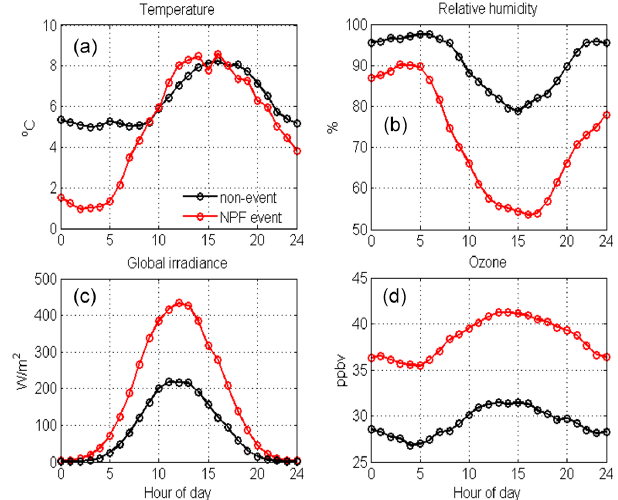
Figure 8. Average (a) temperature ( ◦ C), (b) relative humidity (%), (c) global radiation (Wm − 2 ) and (d) ozone concentration (ppbv) measured at SMEAR I during NPF event (red, n = 33) and non- event days (black, n = 75).